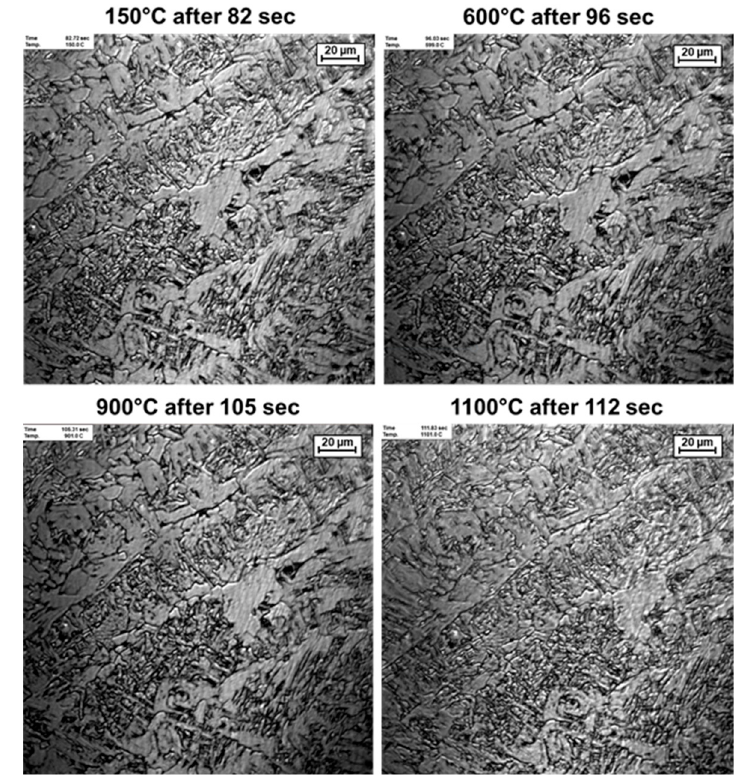
Figure 16. In-Situ microstructural images of a heating cycle.